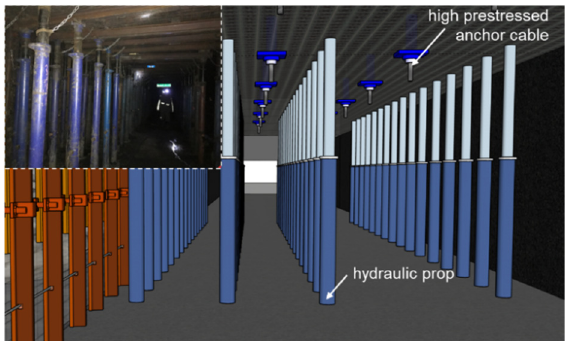
Figure 13. Roadway support parameters.